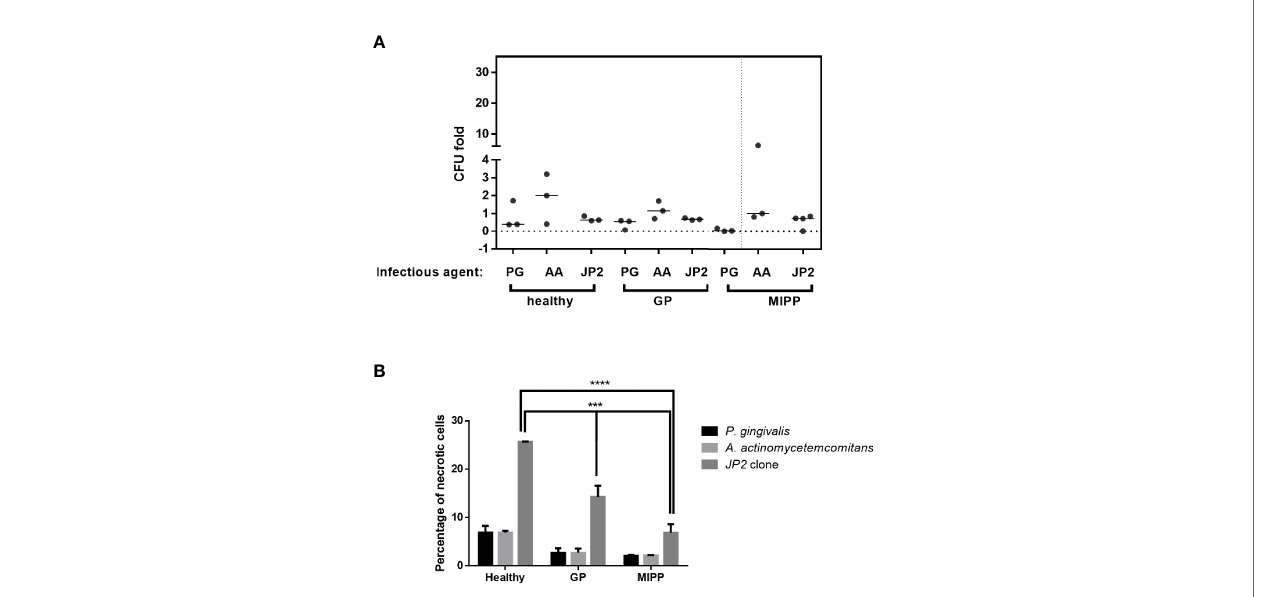
FIGURE 1 | Necrosis of neutrophils exposed to various bacteria. Neutrophils isolated from three periodontally healthy cases, three generalized periodontitis (GP) cases and three molar incisor pattern periodontitis cases were incubated with P. gingivalis (PG), A. actinomycetemcomitans (AA) or the A. actinomycetemcomitans JP2 clone. (A) Colony forming units (CFU) as fold-CFU of the same bacterium without neutrophils. The horizontal bars represent the median for each group. (B) Percentage of necrotic neutrophils (propidium iodide-positive cells in fl ow cytometry analysis). The results are expressed as the mean ± standard error ***P<0.001;